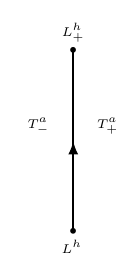
Figure 1 . Kitaev convention for triangle operators acting on an